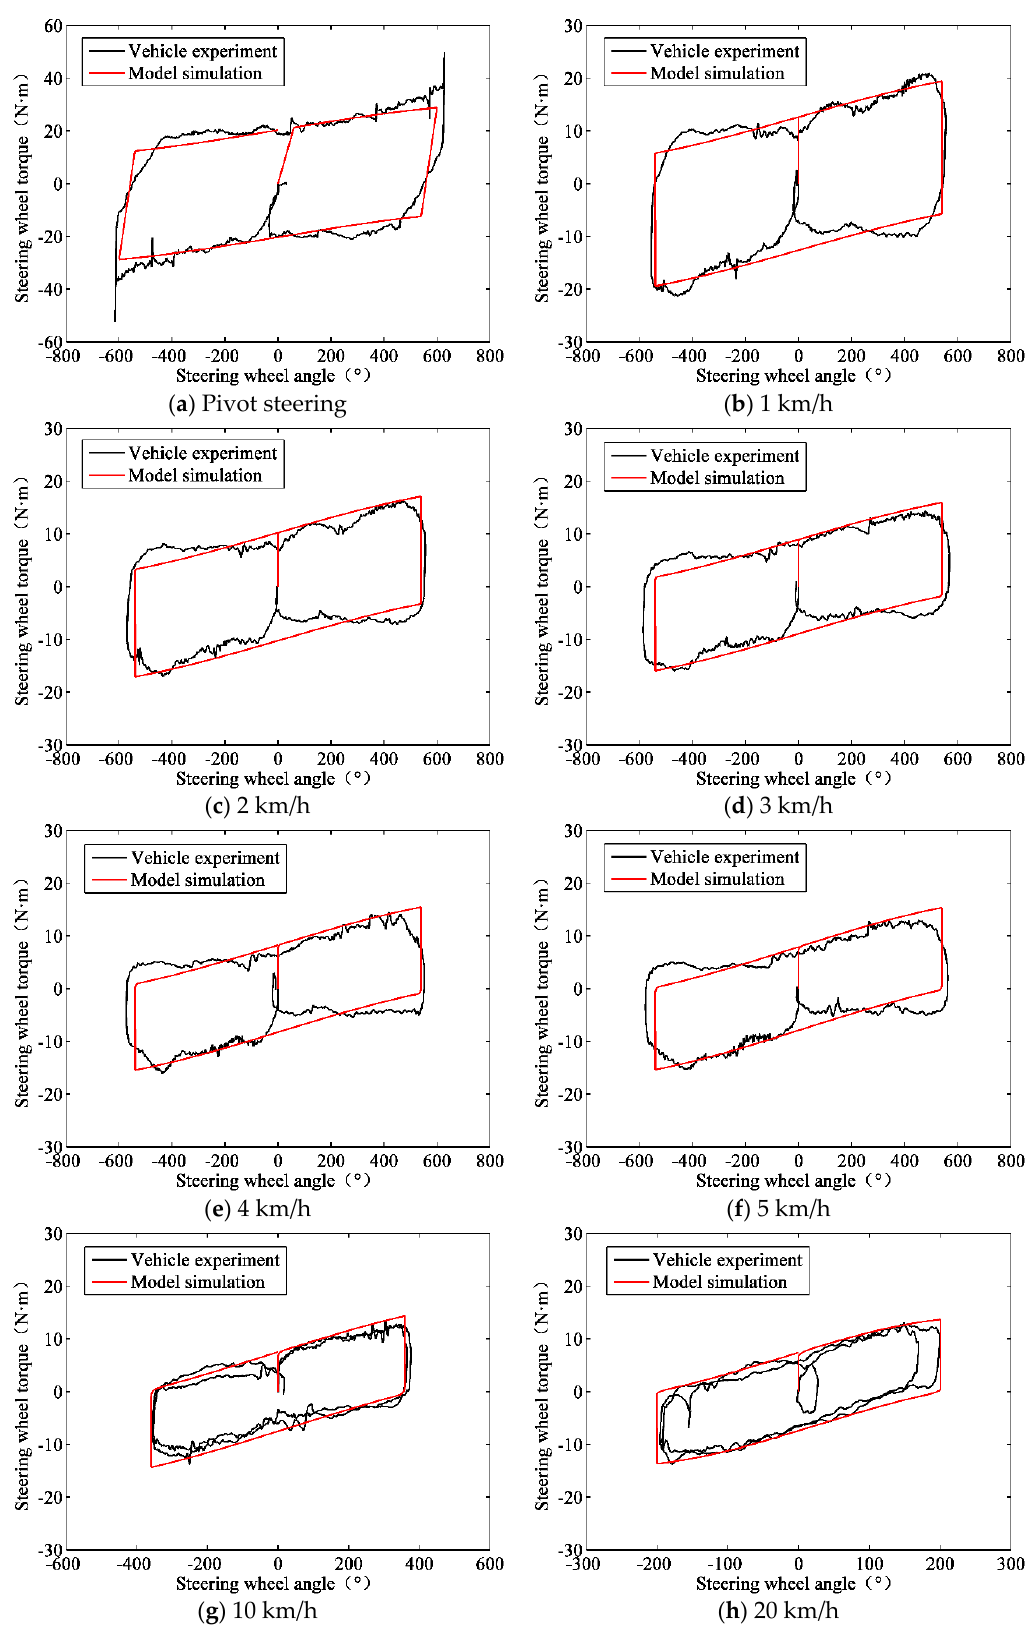
Figure 10. Simulation and experimental results of the steering wheel torque at different speeds.